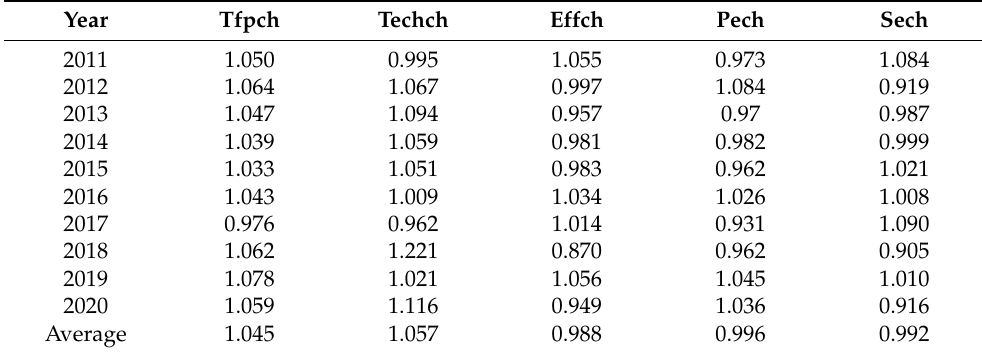
Table 2. Agricultural Tfpch and its decomposition indexes in China,